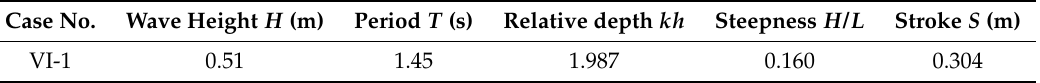
Table 8. Wave parameters for experiment and numerical